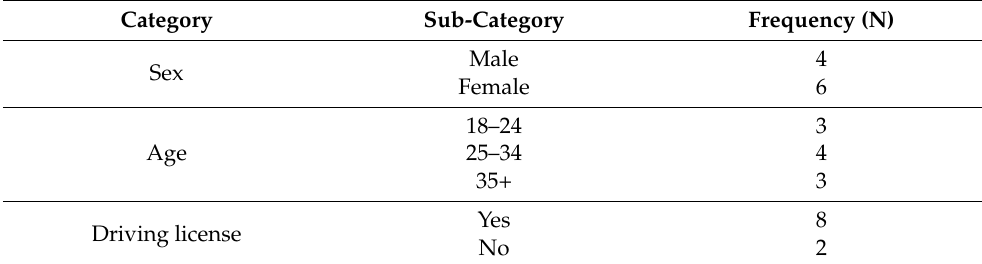
Table 2. Demographic characteristics of